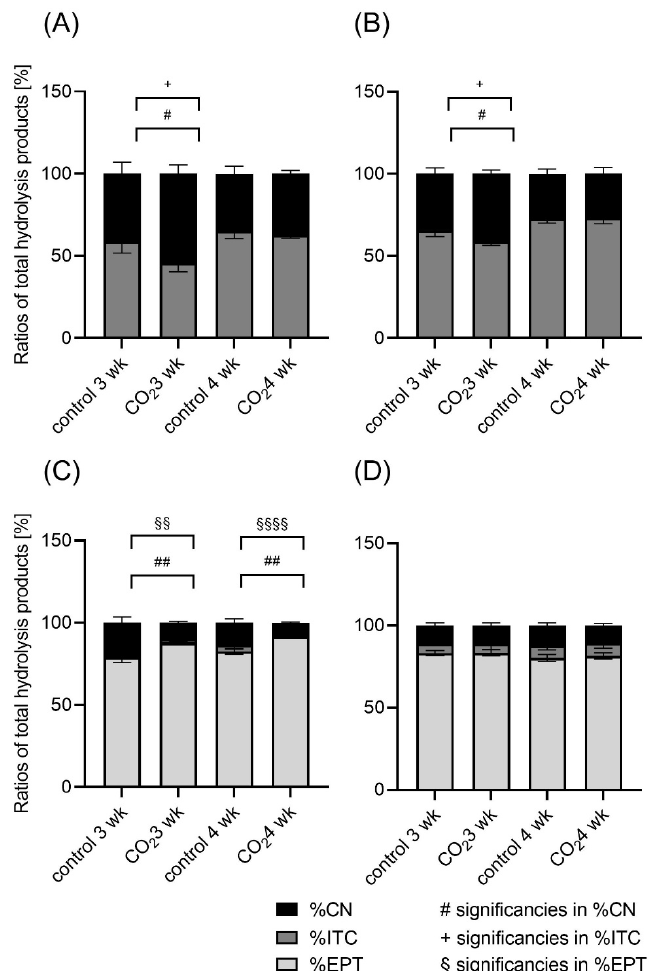
Fig. S3: Effect of elevated CO 2 on the percentage of nitriles (%CN), epithionitriles (%EPT) and isothiocyanates (%ITC) relative to the total glucosino- late hydrolysis products in Hi-0 and Bur-0 after CO 2 treatment for three or four weeks (wk) compared to ambient air (control) shown as relative to the control. Averages and standard deviations of biological replicates (n = 4-5) are shown for two experimental replications (I and II) separately. Significant differences are marked with symbols (*, #, +, §; for example *, p < 0.05; **, p < 0.01; ***, p < 0.005; unpaired t -test).